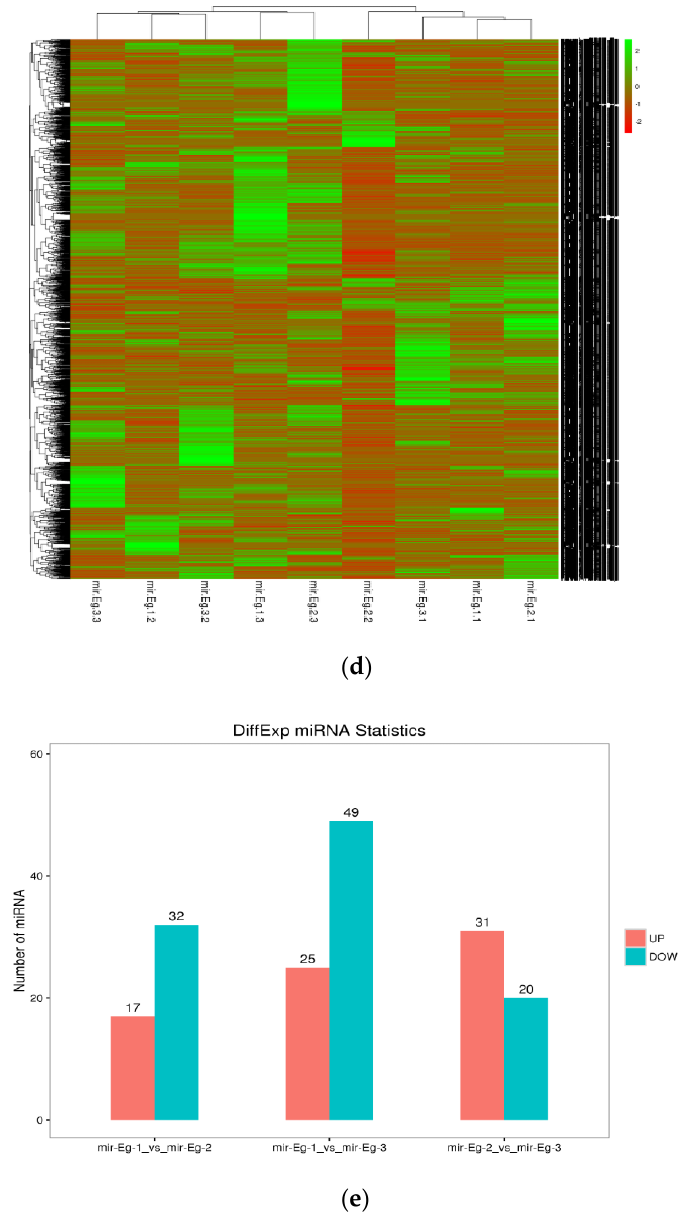
Figure 2. ( a ) Long non-coding RNA (lncRNAs) forecast results Venn diagram. ( b ) Statistical graph of new lncRNA transcripts. ( c ) Cluster diagram of differentially expressed lncRNA patterns between groups. ( d ) Heat map of miRNA expression. Heat maps can be clustered on two dimensions (samples, miRNA), and the topological relationship of clustering can be used to observe the relationship between samples or between miRNAs. In order to eliminate data noise, miRNAs with TPM < 1 are filtered out for heat map analysis. Based on miRNA expression, the relationship between samples and miRNA was hierarchically clustered, and the results of clustering were presented by heat map. ( e ) Statistical graph of miRNA differential expression between groups.